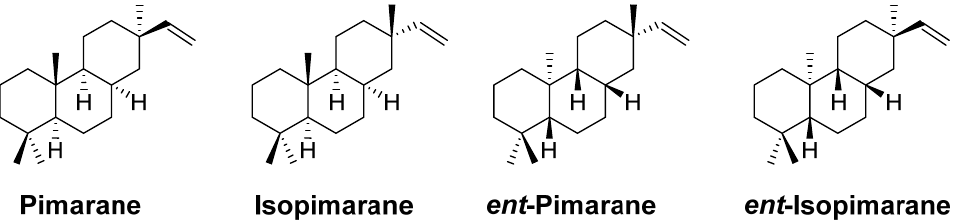
Figure 1. Structures of four kinds of pimarane diterpenes.